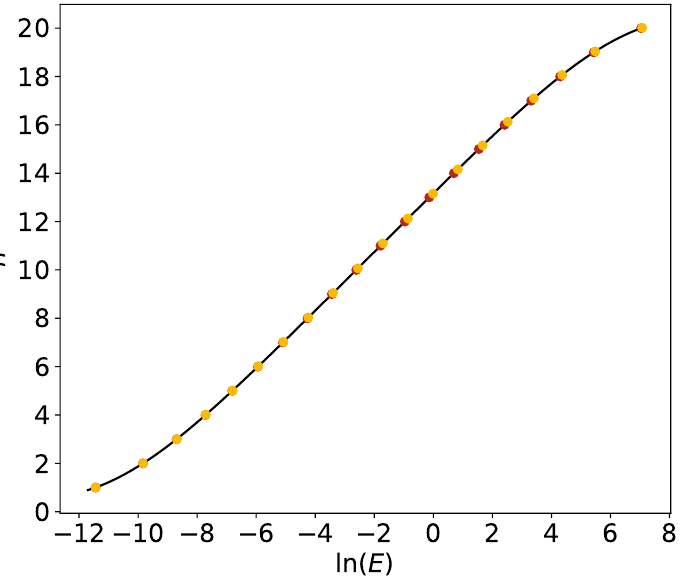
( 0 ) = g ( ln E ) n . Black line: the function n